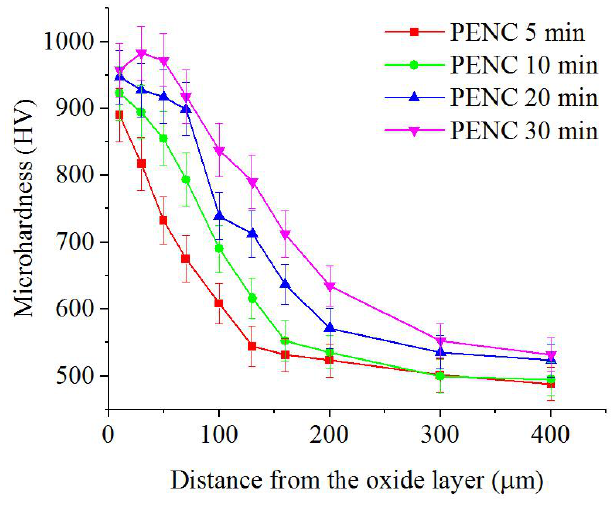
Figure 7. Microhardness distribution in the nitrocarburized layer after cathodic PENC.